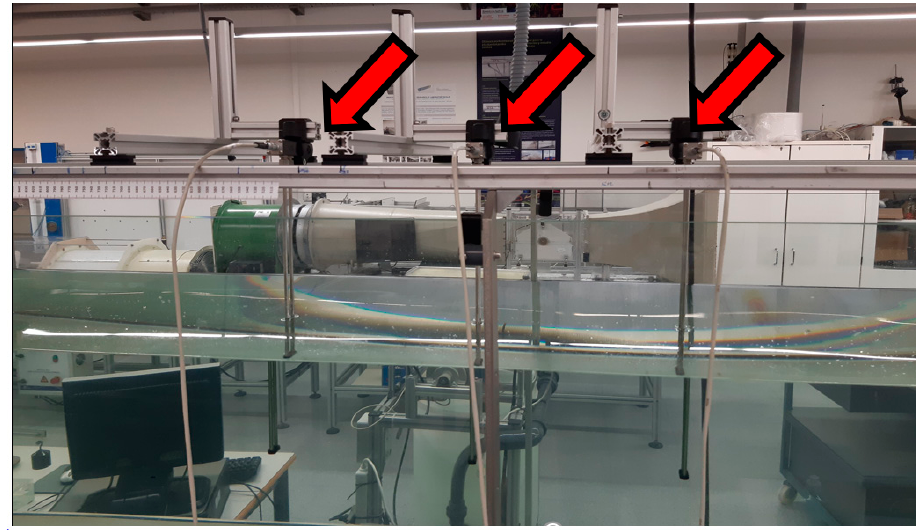
Figure 2. Disposition of the resistive probes in the EWF. The arrows highlight the join with the structure that allows them to move along the flume.